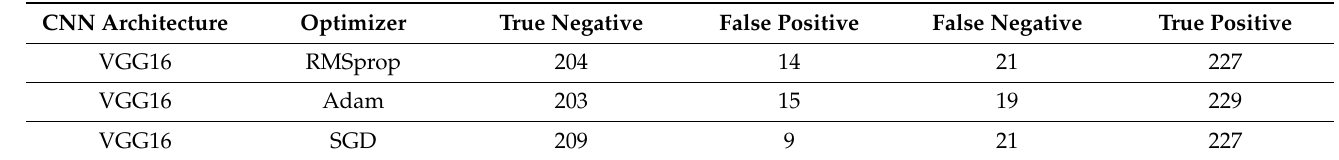
Table 6. VGG16 confusion matrix (validation).